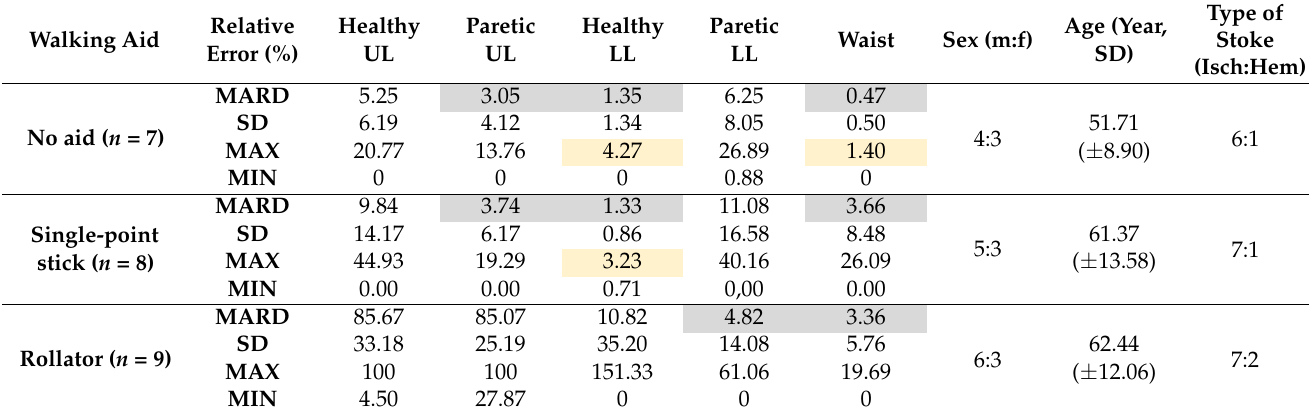
Table 1. Mean absolute relative difference (MARD) and standard deviation (SD) for each group with and without a walking aid. UL—upper limb, LL—lower limb, m—male, f—female, SD—standard deviation, Isch—Ischemic stroke, Hem—Hemorrhagic stroke. Gray-colored cells indicate that the MARD did not exceed 5%. Yellow-colored cells indicate that none of the measured values exceeded the relative error of